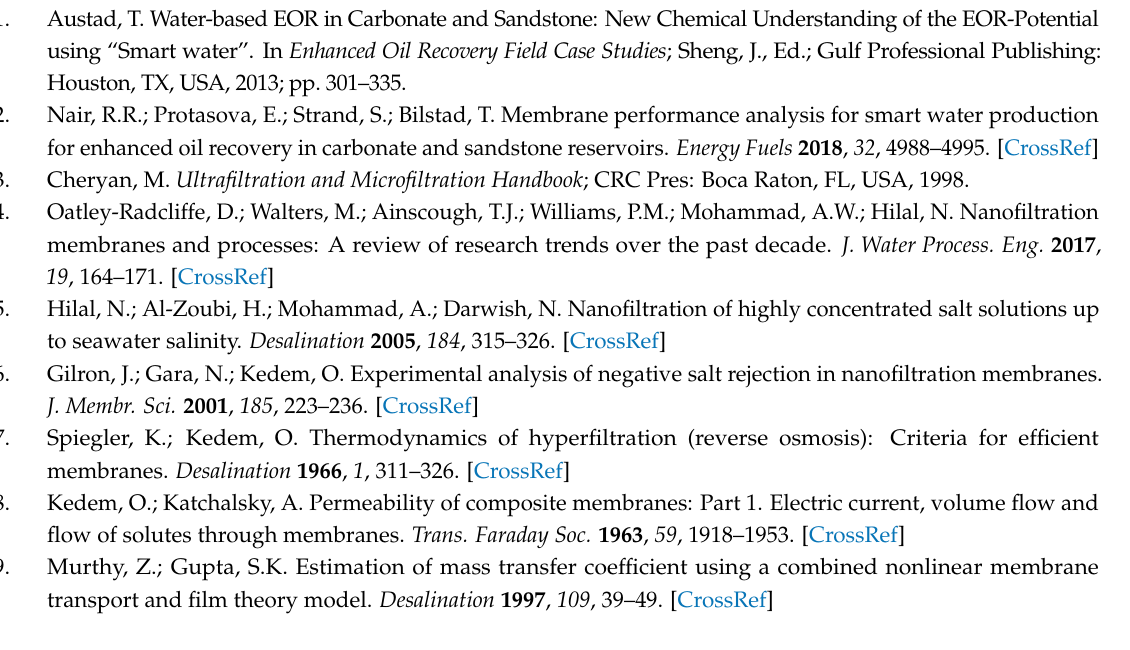
Figure S1: Rejection versus flux for Na + for ESNA fitted using Spiegler–Kedem model, Figure S2: Rejection versus flux for Na + for HYDRACoRe10 fitted using Spiegler–Kedem model, Figure S3: Rejection versus flux for Na + for HYDRACoRe50, Figure S4: Rejection versus flux for Na + for NF270, Figure S5: Rejection versus flux for Na + for SR 90, Figure S6: Rejection versus flux for Na + for NANO SW, Figure S7: Rejection versus flux for Na + for all NF